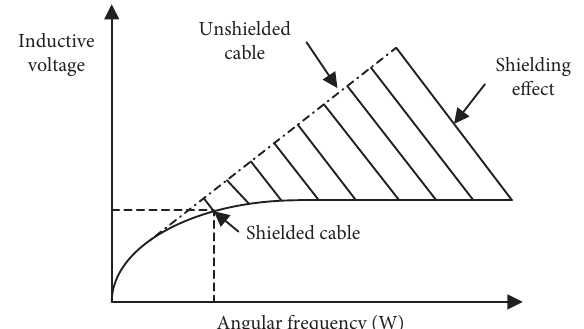
Figure 4: Relationship between induced voltage and